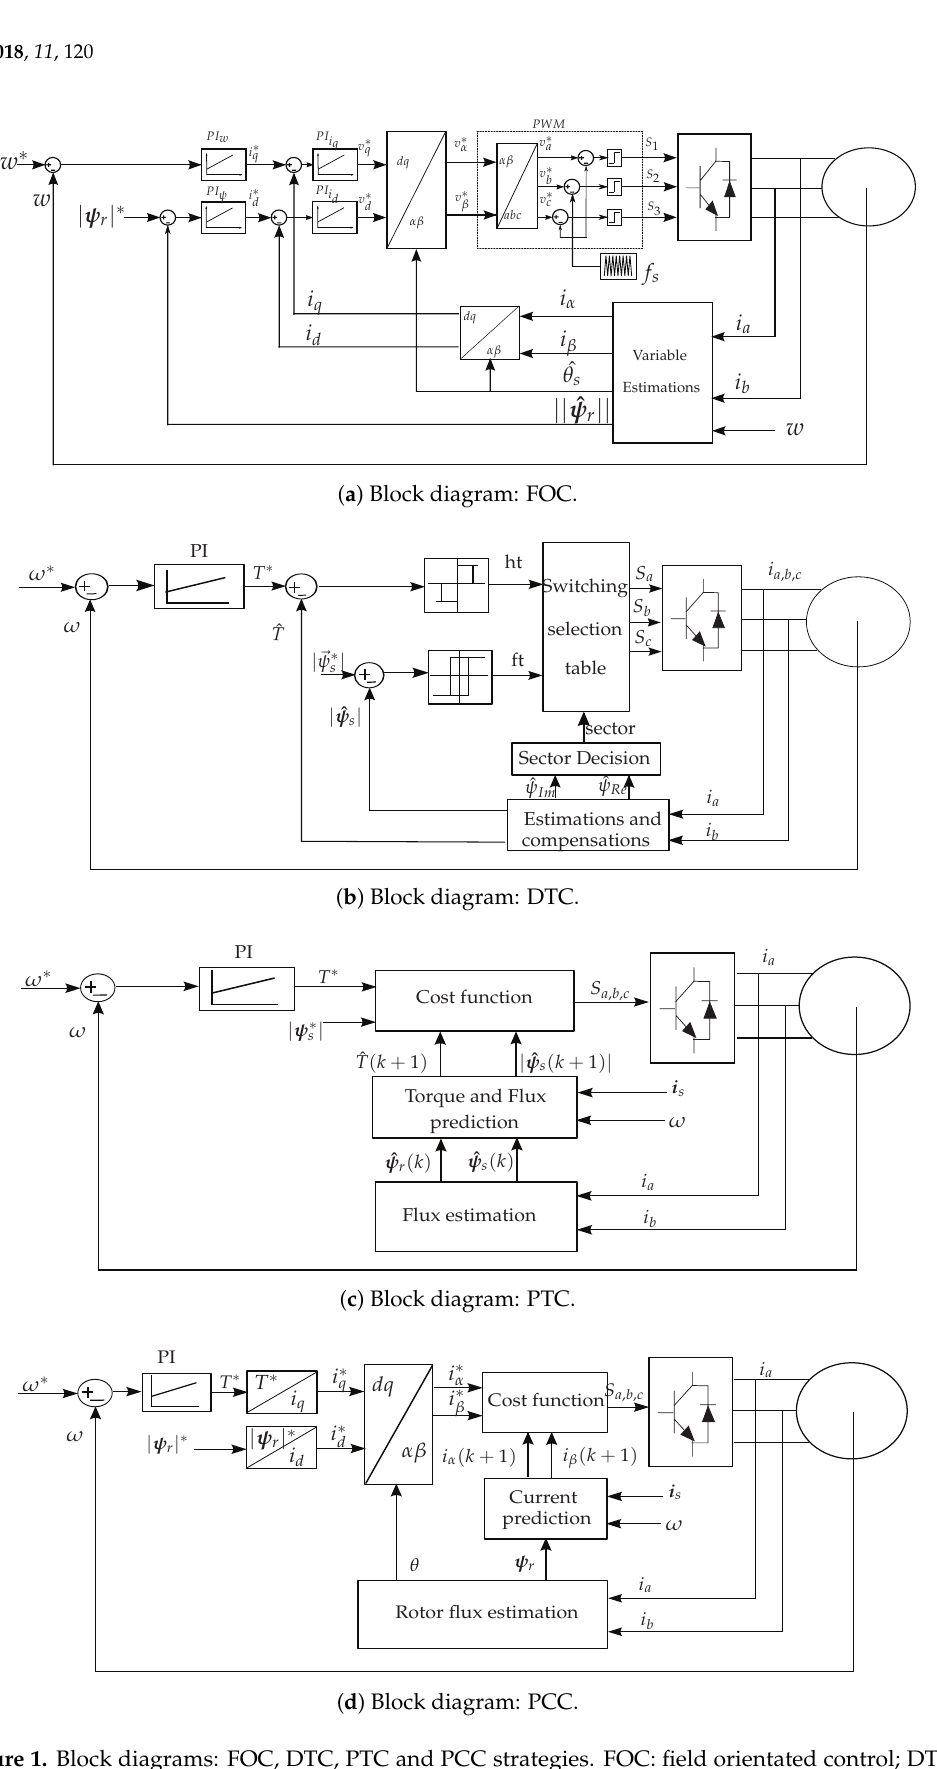
Figure 1. Block diagrams: FOC, DTC, PTC and PCC strategies. FOC: field orientated control; DTC: direct torque control; PTC: predictive torque control; PCC: predictive current